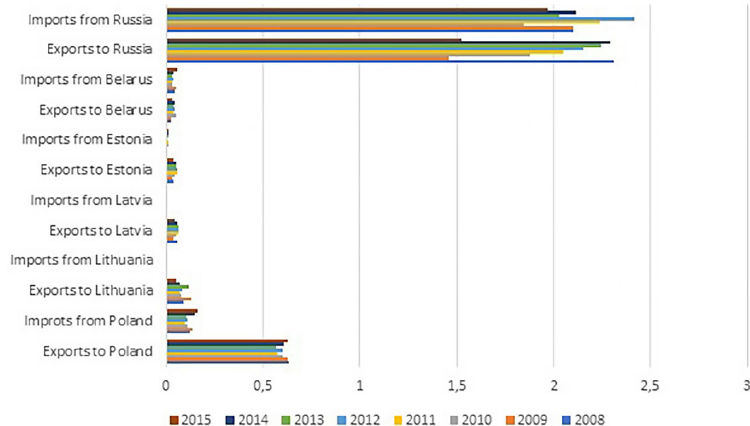
Fig. 3. Percentage share of the researched countries as a direction of the Chinese imports and exports Source : own calculation based on IMF (2011, 2015, 2016).